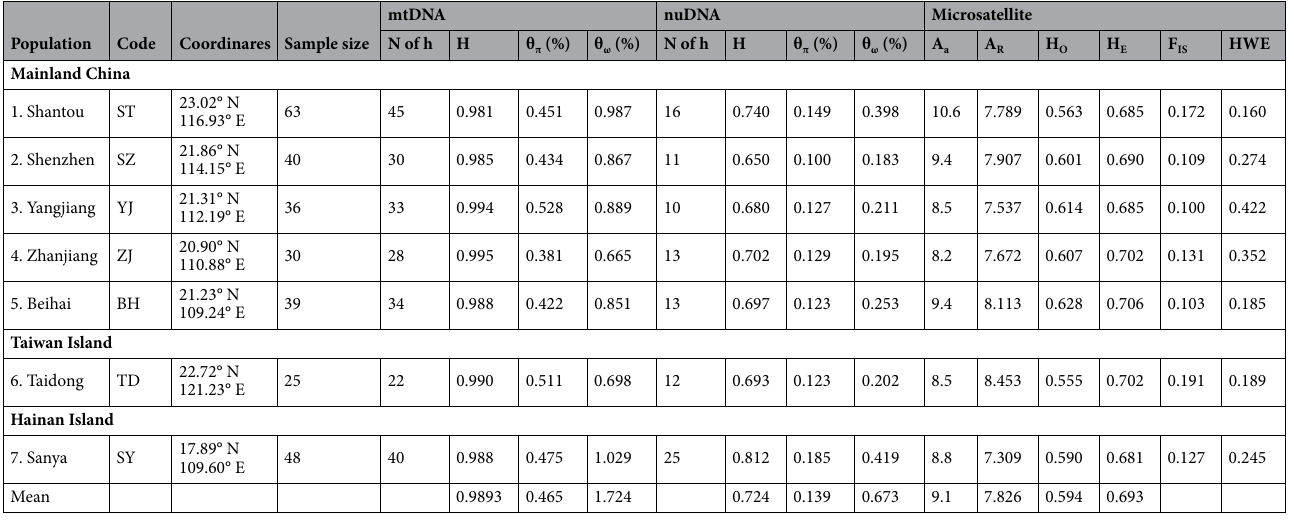
Table 1. Samples used for analysis, location, code and summary statistics. a Number of haplotypes; b Haplotype diversity; c,d Nucleotide diversity; e Average number of alleles; f Mean allelic richness; g Mean observed heterozygosity; h Mean expected heterozygosity; i Mean level of inbreeding observed; j Hardy–Weinberg